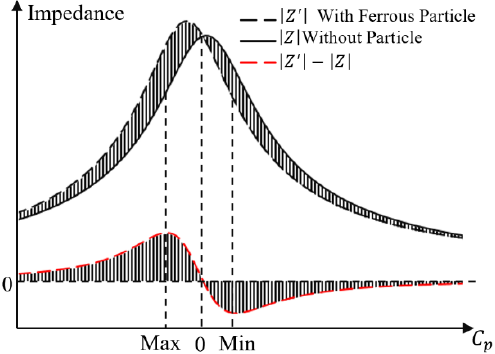
Figure 10. Schematic of impedance development with and without the ferrous particles passing through the coil and the calculated impedance difference.